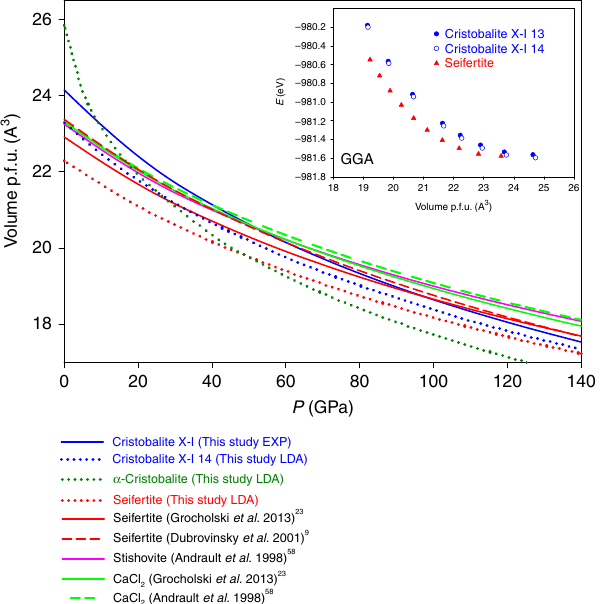
Figure 4 | Molecular volume of various silica phases as a function of pressure. They are calculated according to experimental equations of state given in refs 9,23,58 or implementing density-functional theory (DFT) with local-density approximation (LDA), starting from known structures 59,60 . Cristobalite X-I appears to be denser even than seifertite above about 100GPa (experimental values). The theoretical structure of seifertite is about 3.5% denser than the experimental one, a characteristic limitation of the LDA functional. According to LDA, alpha-cristobalite would be the densest phase above ca. 50GPa, but it has never been observed experimentally above 15GPa. Generalized-Gradient approximation (GGA) calculations for seifertite and the two cristobalite X-I ordered phases are represented in the inset. See Supplementary Fig. 8 for E – V curves of other phases.